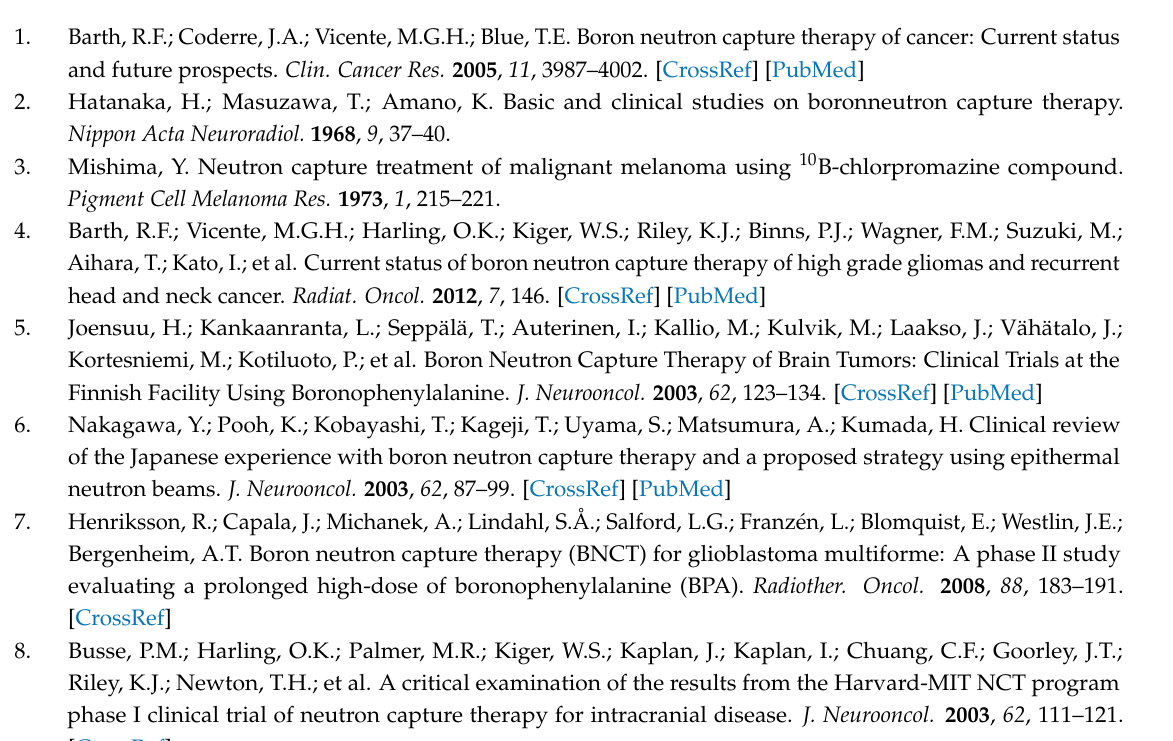
Figure S1: 1 H-NMR spectra of (a) PBA monomer and (b) PBA(protected) monomer in DMSO-d6 solvent at 400 MHz (JEOL ECX400P spectrometer) and ambient temperature. Figure S2: 1 H-NMR spectra of (a) poly(NIPAAm) in CDCl 3 solvent and (b) poly(NIPAAm- co -PBA) in CD 3 OD solvent at 400MHz (JEOL ECX400P spectrometer) and 25 ◦ C. Figure S3: GPC chromatograms of poly(NIPAAm), poly(NIPAAm- co -PBA) and poly(NIPAAm- block -NIPAAm- co -PBA). The GPC measurements were performed by using THF as a mobile phase at 40 ◦ C and the flow rate of 1.0 mL · min − 1 . Figure S4: Temperature dependence of optical transmittance of poly(NIPAAm) (open circle) and poly(NIPAAm- co -PBA) (open square) dissolved in pure water. Figure S5: Concentration dependence of optical transmittance of poly(NIPAAm- block -NIPAAm- co -PBA) dissolved in pure